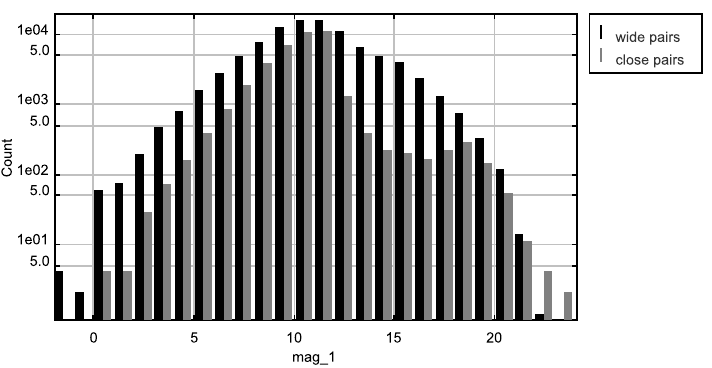
Fig. 5. The distribution the primary magnitude m 1 of wide ( (cid:26) (cid:21) 2 arcsec) and close binaries (the black and gray bars,